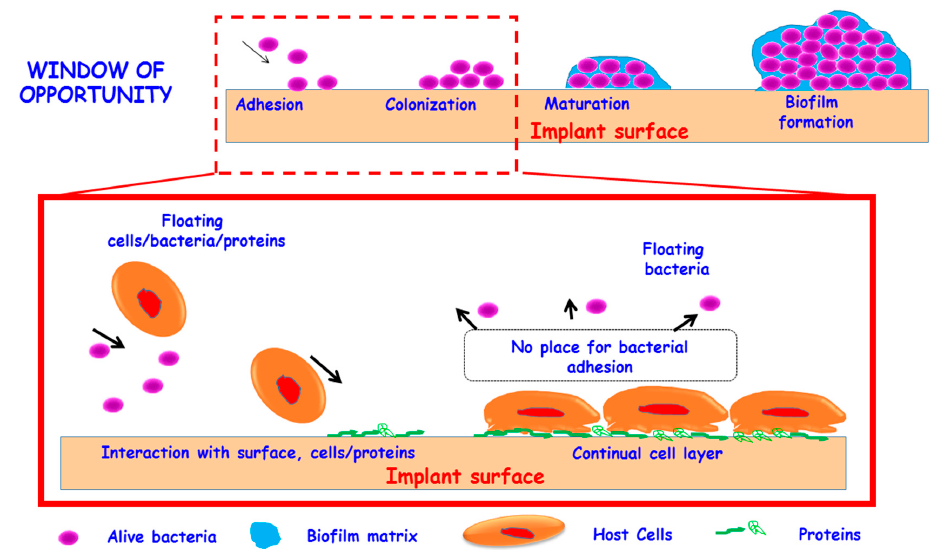
Figure 1. Concept of “race for the surface” and significance of “window of opportunity” in the development of implants capable to be colonized by host cells, while impede bacteria adhesion and the formation of the biofilm.